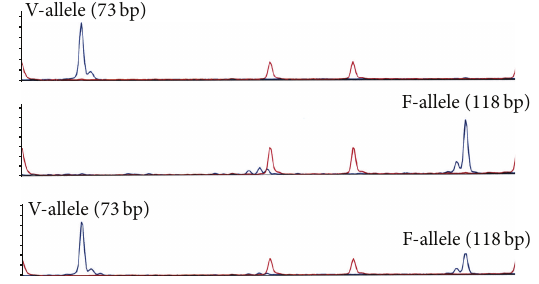
Figure 1: Fc 𝛾 RIIIA polymorphism genotyping. Upper line: patient homozygous for the Fc 𝛾 RIIIA p.158 V-allele, 2nd line: patient homozygous for the Fc 𝛾 RIIIA p.158 F-allele, lower line: heterozy- gous for the Fc 𝛾 RIIIA p.158 V and